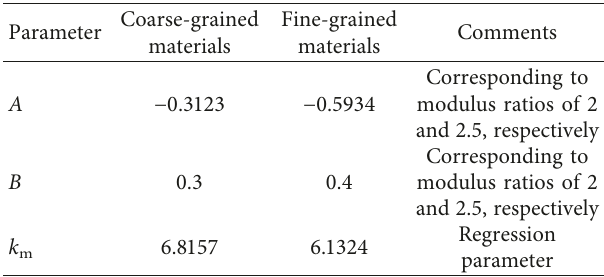
Table 1: Values of a , b , and k materials.